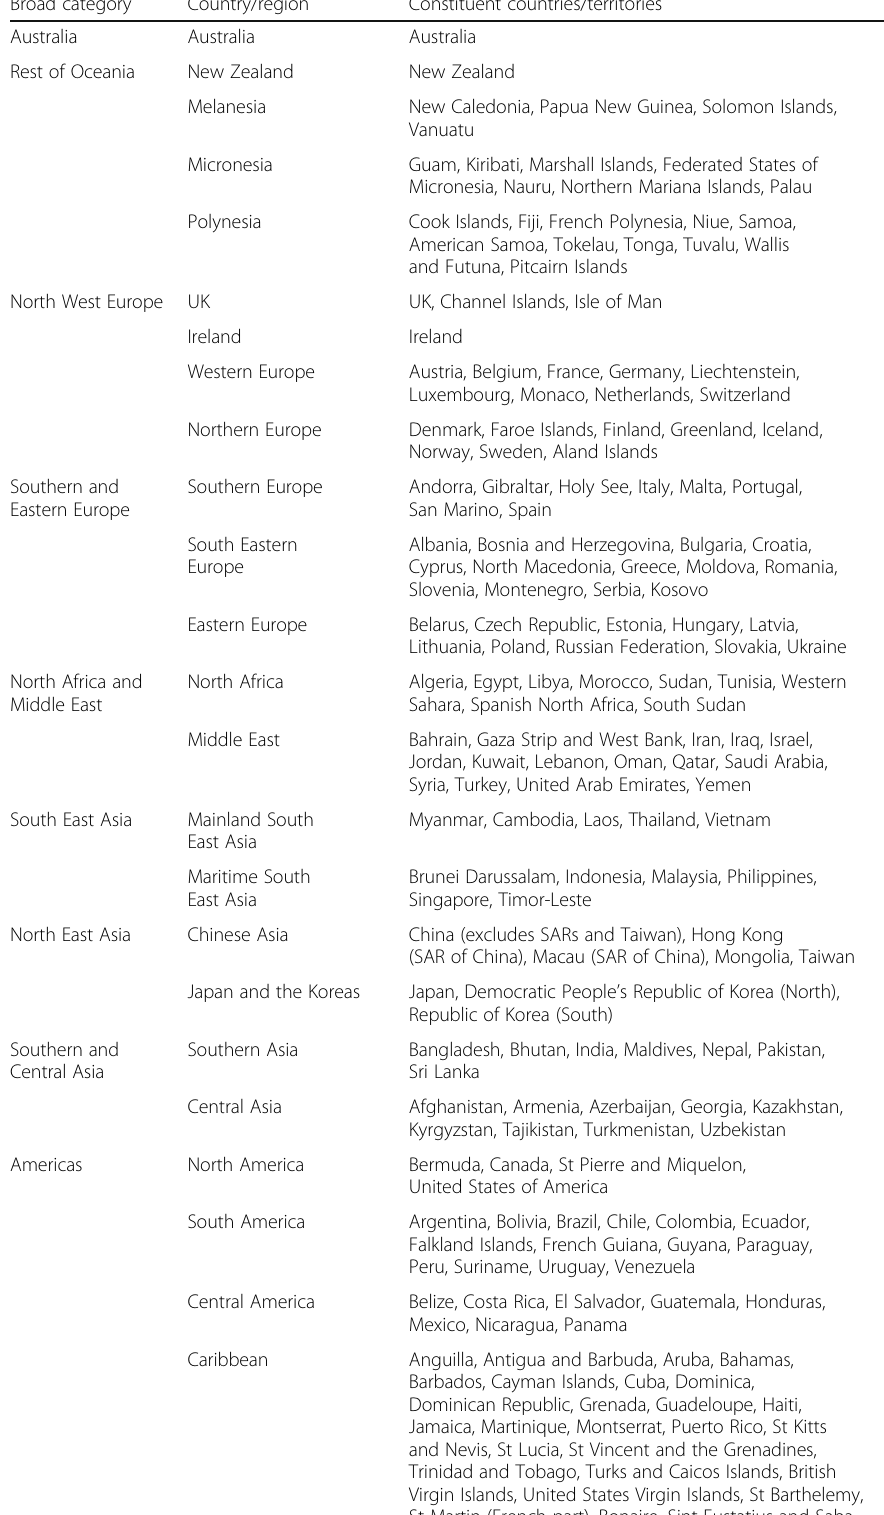
Table 4 The classification of countries of